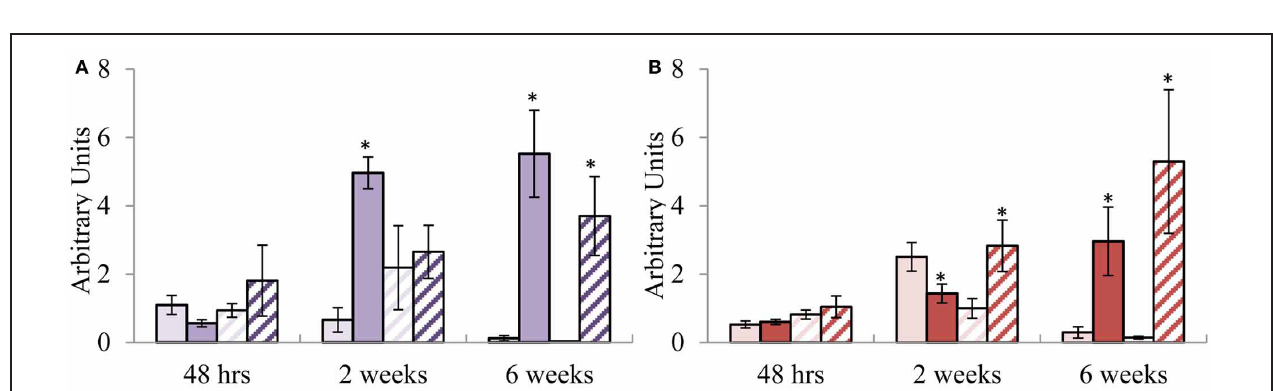
Samples were normalized with EgrARF and EgrFBA . Error bars are show the standard error of the mean of the biological replicates ( n = 3). White boxes represent the control samples whereas the colored boxes represent the treated samples. Significance between the control and treated samples is indicated by ∗ at a specific time point and was calculated by the Kruskal–Wallis test ( p < 0 . 05).